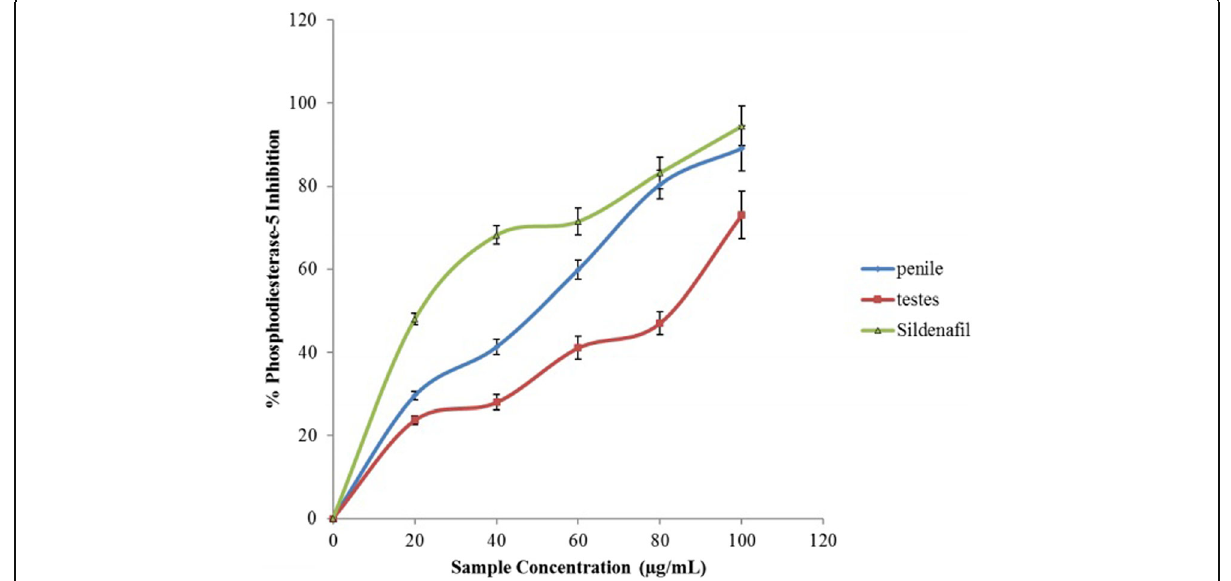
Fig. 1 Inhibition of Phosphodiesterase-5 activity in rats ’ genitals by aqueous extract from Ocimum gratissimum